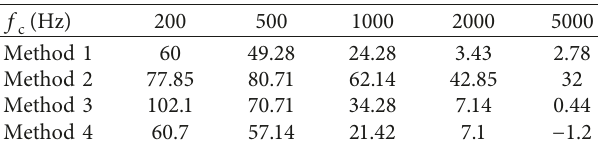
Table 5: Influence of the cutoff filter frequency on the first-moment 100km. fault location error, l real (cid:31)